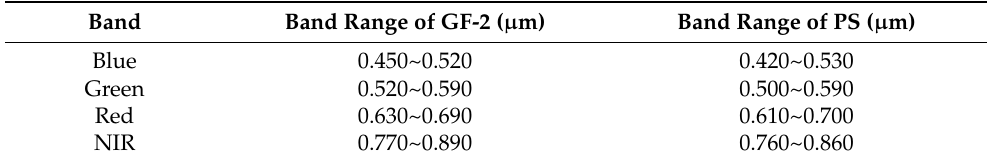
Table 1. GF-2 PMS and PS image spectral ranges. Band Band Range of GF-2 ( µ m) Band Range of PS ( µ m) Blue